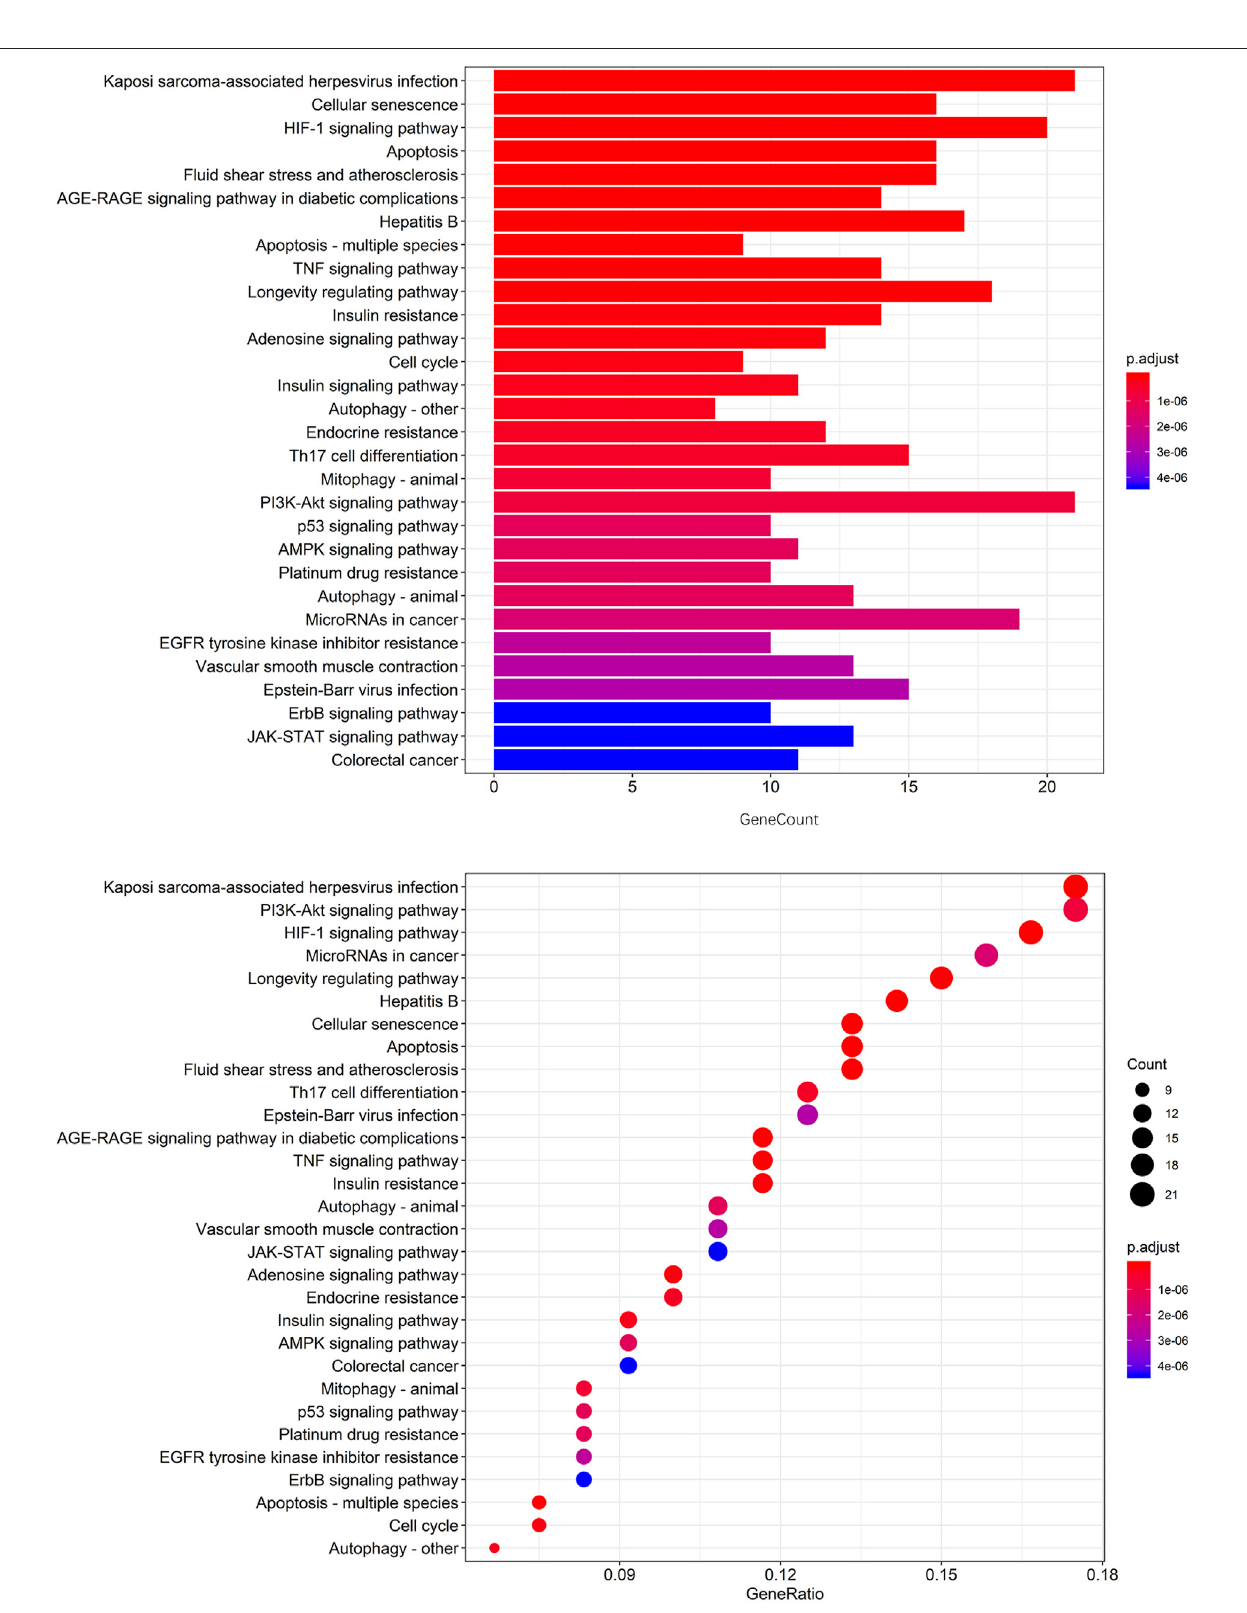
FIGURE 4 | The top 30 signaling pathways from KEGG analysis.